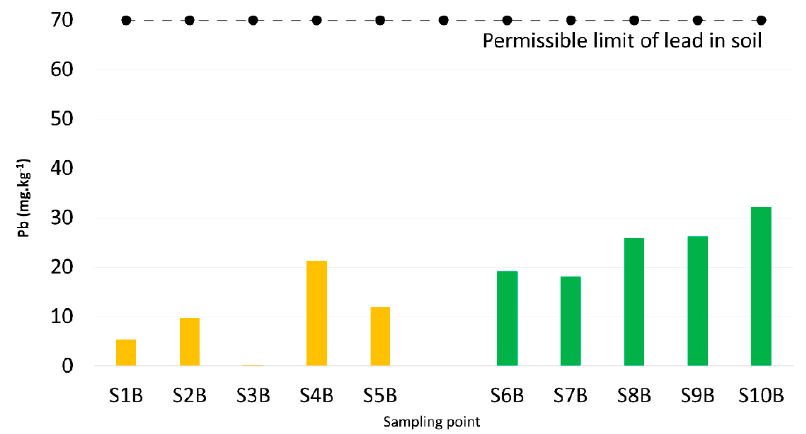
Figure 2. Comparison of soil lead concentrations measured from the two types of land areas near to and far away from the bus station.